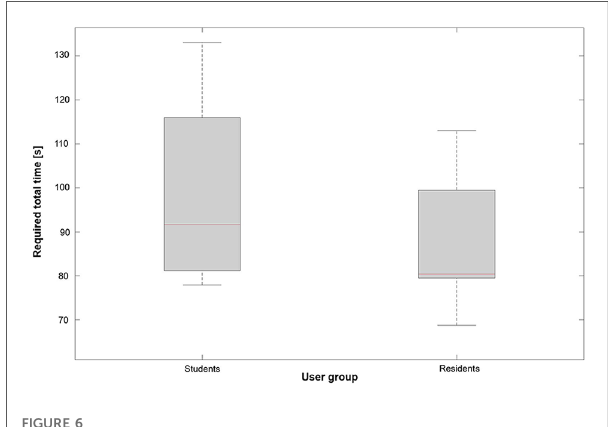
FIGURE 6 Required total time needed to complete the tasks for each user